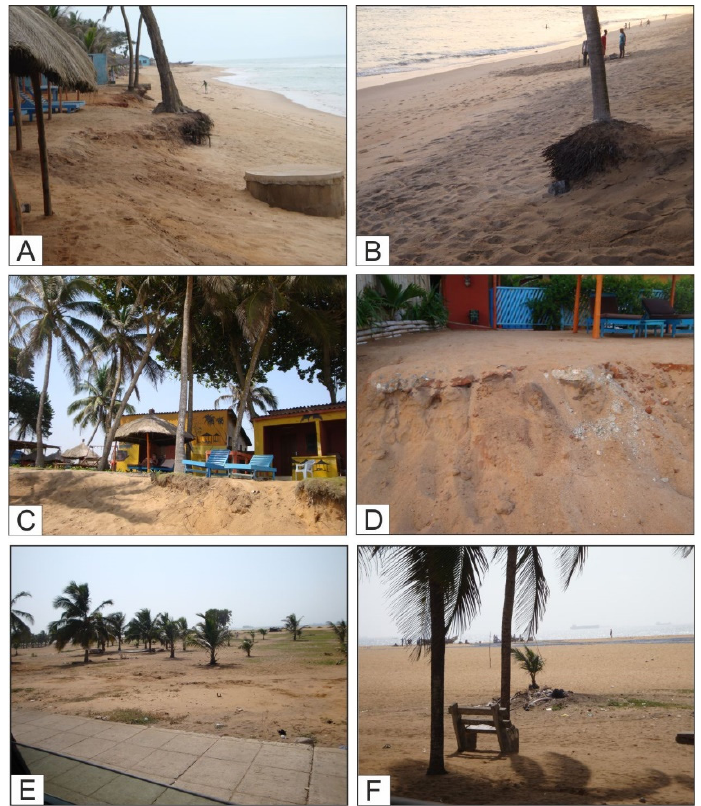
Figure 6. Geomorphological erosional and growth forms along the beaches of the coast of Togo. ( A – D ), erosional forms to the east of the port of Lomé; ( E , F ), expanding beaches (about 400 m wide) to the west of the port of Lom é . Field observations carried out in January 2018 and January